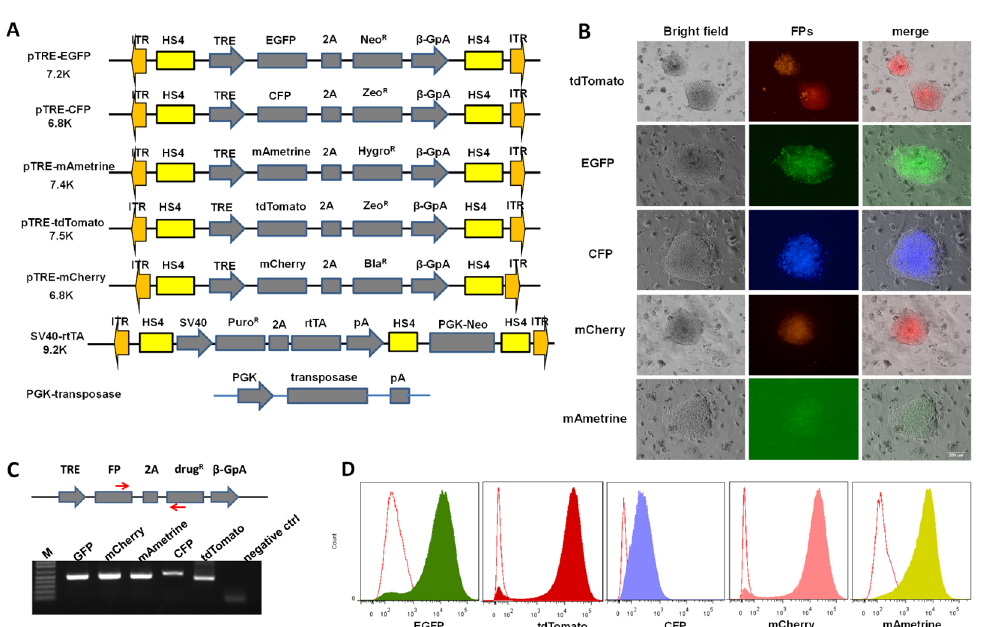
Fig. 5. Generation of ES cell reporter cell line with multiple fluorescence proteins co-expression. (A) Schematic representation of inducible fluorescence protein expressing cassettes in the context of PiggyBac backbone. (B) Imaging of generated individual fluorescence reporter under different excitation light. Note that mAmetrine fluorescence was photographed under blue light thus has weak signal. The scale bar is 200 m m. (C) Genotyping analysis of generated ES cell reporter with five fluorescence proteins coexisted in single ES cell. (D) Flow analysis of generated No.12 multiple fluorescence protein stable ES cells. The thin red line on the left is the histogram without doxycline treatment as the negative control.